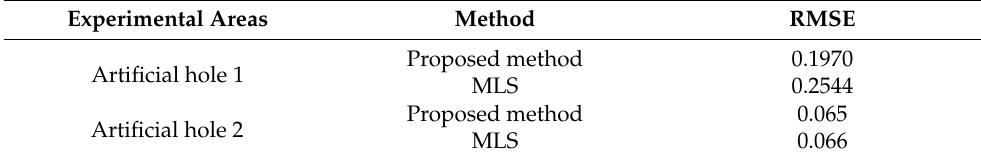
Table 2. Comparison of RMSE values of the proposed method and moving least square method.